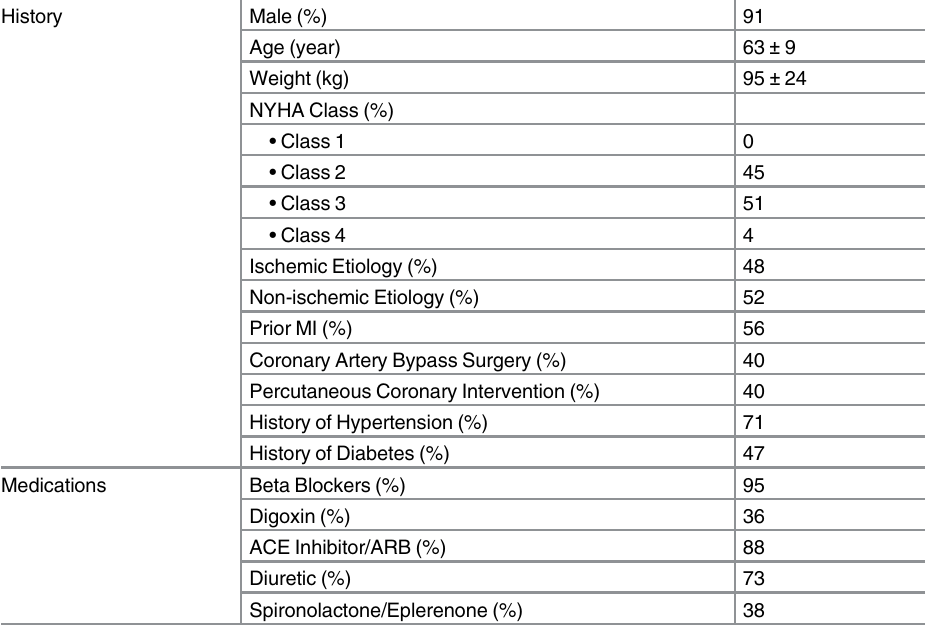
Table 1. Characteristics of Study Population (n = 56).